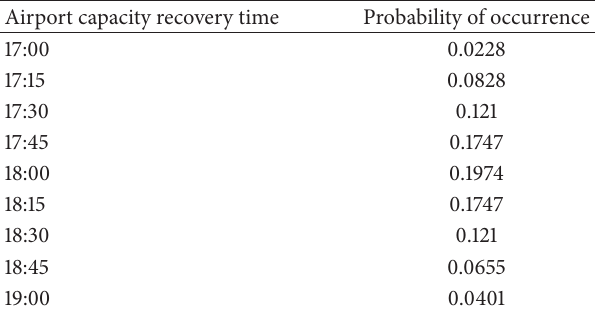
Table 1: Probability distribution of airport capacity recovery time 𝜉 .